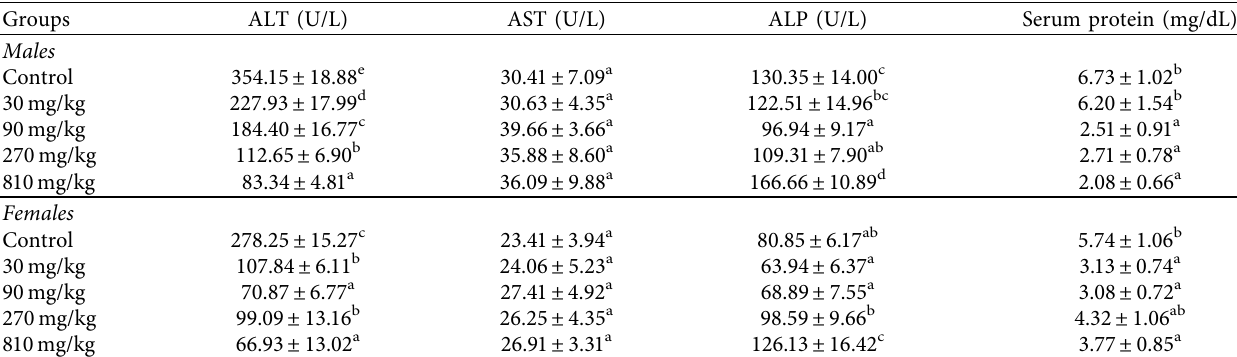
Table 5: Effect of aqueous extract of T. grandis leaves on liver function markers of animals.